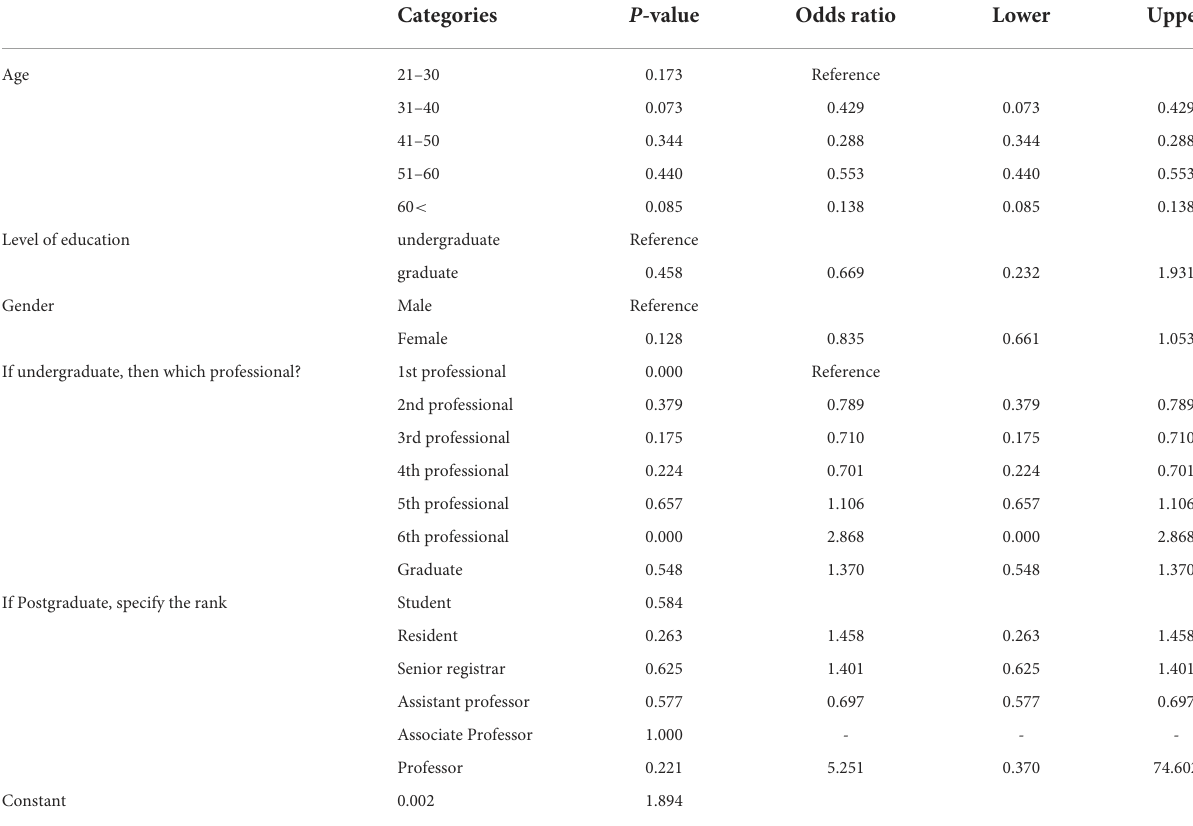
TABLE 8 Binary logistic regression between baseline characteristics of the study population and the attitude toward artificial intelligence **